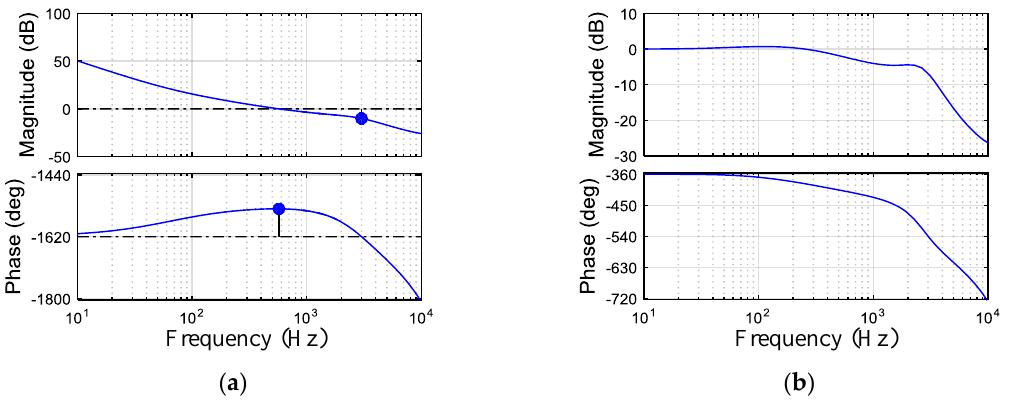
Figure 16. Frequency characteristics of the voltage loop with discrete control: ( a ) Open-loop Bode diagrams; ( b ) Close-loop Bode diagrams.